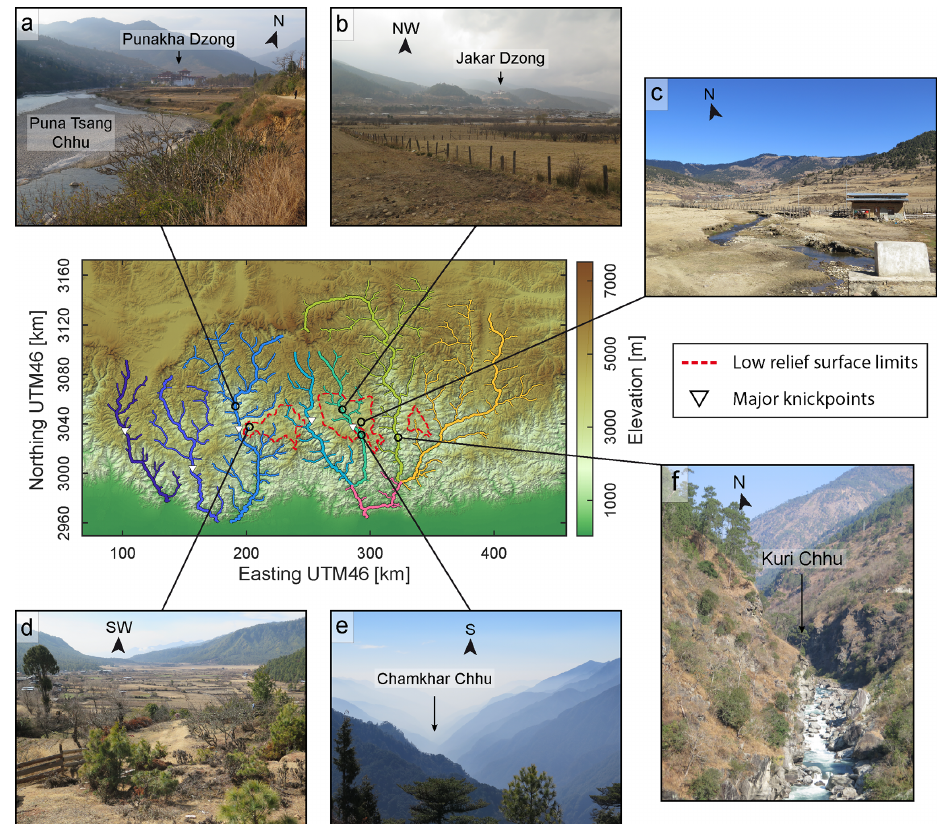
Figure 3. Field pictures representative of the various landscapes in the hinterland of the Bhutan Himalaya. Topographic map in the center locates field pictures relative to low-relief regions (contoured with red dashed line) and to major knickpoints along rivers (rivers color- coded as in Figs. 1 and 2). (a) Alluvial plain along the Puna Tsang Chhu, upstream of its major knickpoint. Picture taken near the Dzong of Punakha. (b) Alluvial plain along the Chamkhar Chhu (Bumthang surface), upstream of its major knickpoint. Picture taken near Jakar. (c) High-altitude low-relief area of Ura (south-easternmost portion of the Bumthang surface). (d) High-altitude low-relief area of Kotakha (westernmost portion of the Phobjikha surface). (e) Deep gorge south of the major knickpoint along the Chamkhar Chhu. (f) Canyon along the Kuri